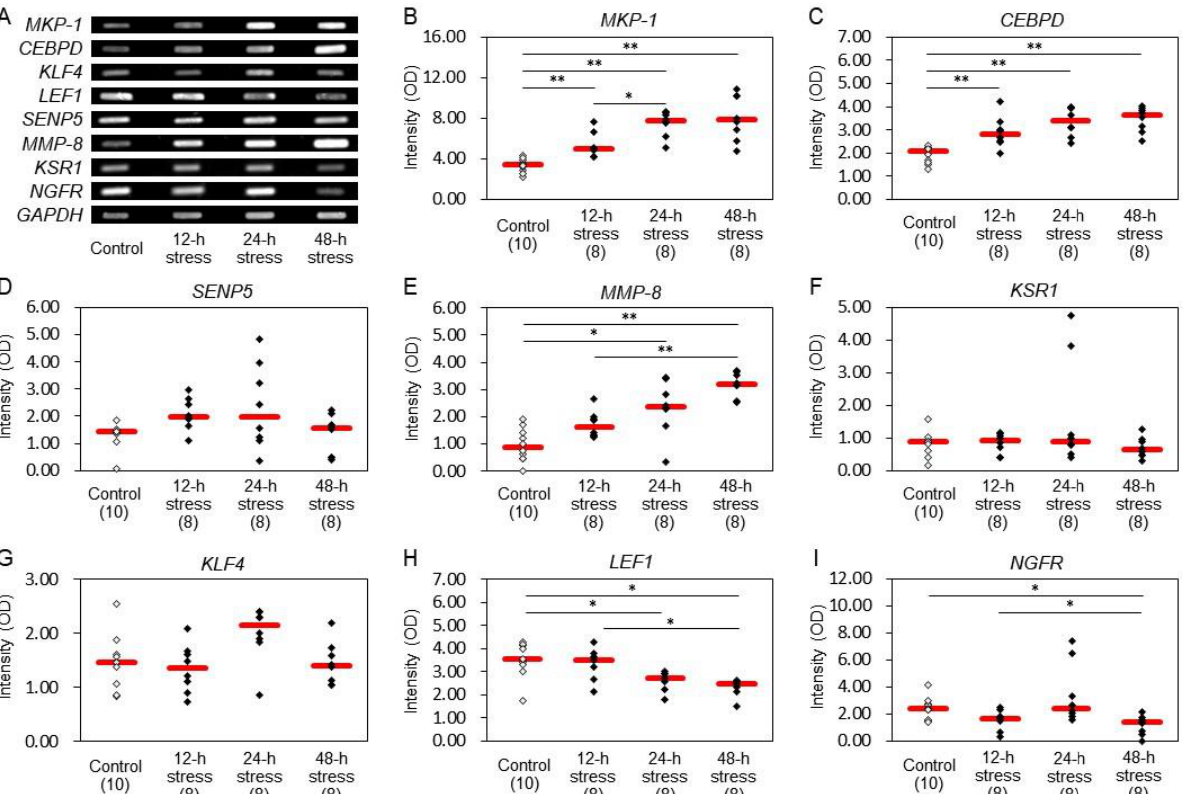
Figure 6. Gene expression profiles in the rat peripheral blood. After exposure to stress, blood was collected, and mRNA expression was determined by RT-PCR. The intensities of optical densities are expressed relative to GAPDH expression in each sample. In preliminary experiments, we clarified the PCR cycle number at which the expression level of each gene saturated, and we adopted the PCR cycle number lower than the gene expression level saturating in the present study. The OD obtained from each sample was verified to be within the range in which the relationship between the amount of DNA and its OD was linear. ( A ) Representative gene expression bands of 8 kinds of genes and GAPDH by electrophoresis after RT-PCR. ( B ) MKP-1 ; ( C ) CEBPD ; ( D ) SENP5 ; ( E ) MMP-8 ; ( F ) KSR1 ; ( G ) KLF4 ; ( H ) LEF1 ; ( I ) NGFR . The intensities of optical densities are expressed relative to GAPDH expression in each sample. Red bars represent the median. Parenthesis: the number of animals. * p < 0.05, ** p < 0.01 by Steel − Dwass test. Stress for 12 h, 24 h, and 48 h induced a significant increase in the expression of MKP-1 and CEBPD . MMP-8 expression was significantly increased after 12 h and 24 h stress. On the other hand, the expression of LEF1 was significantly decreased by 24 h and 48 h stress. After 48 h stress, NGFR expression was significantly decreased.